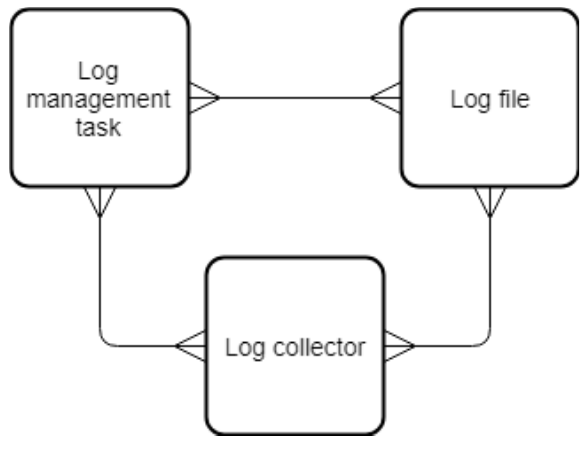
Figure 2. Entity relationships